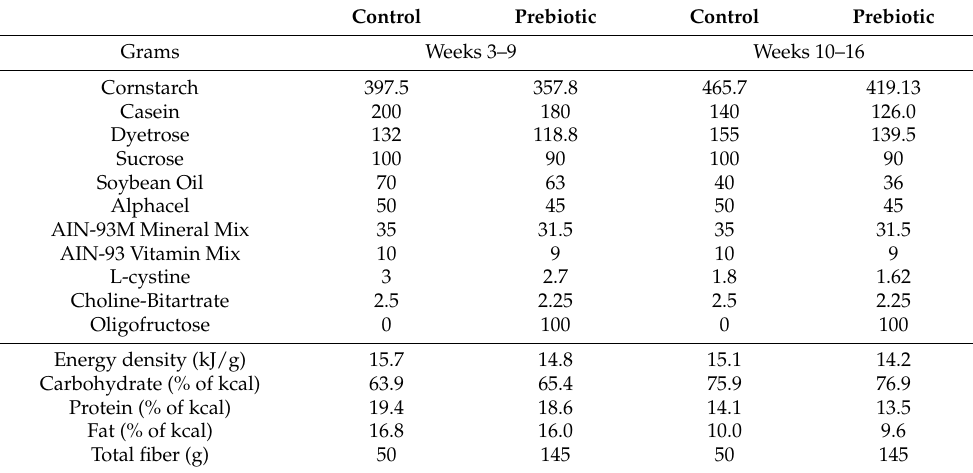
Table 1. Experimental diet composition from 3 to 9 and 10 to 16 weeks of